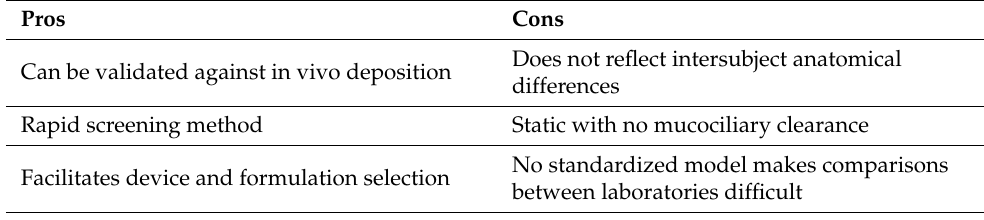
Table 1. Pros and cons of nasal casts. Pros